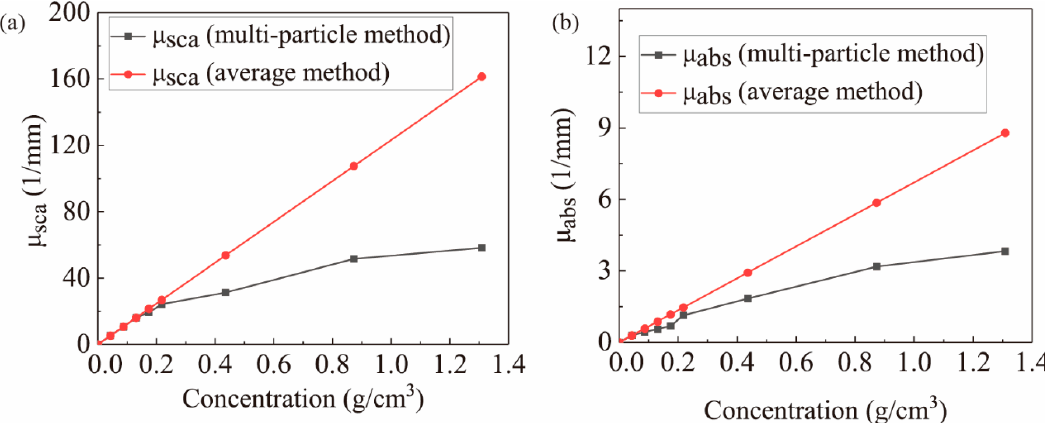
Figure 7. Results comparison of the multi-particle method and average method. ( a ) The results of relationship between the μ sca value and concentration. ( b ) The relationship between the μ abs value and concentration.